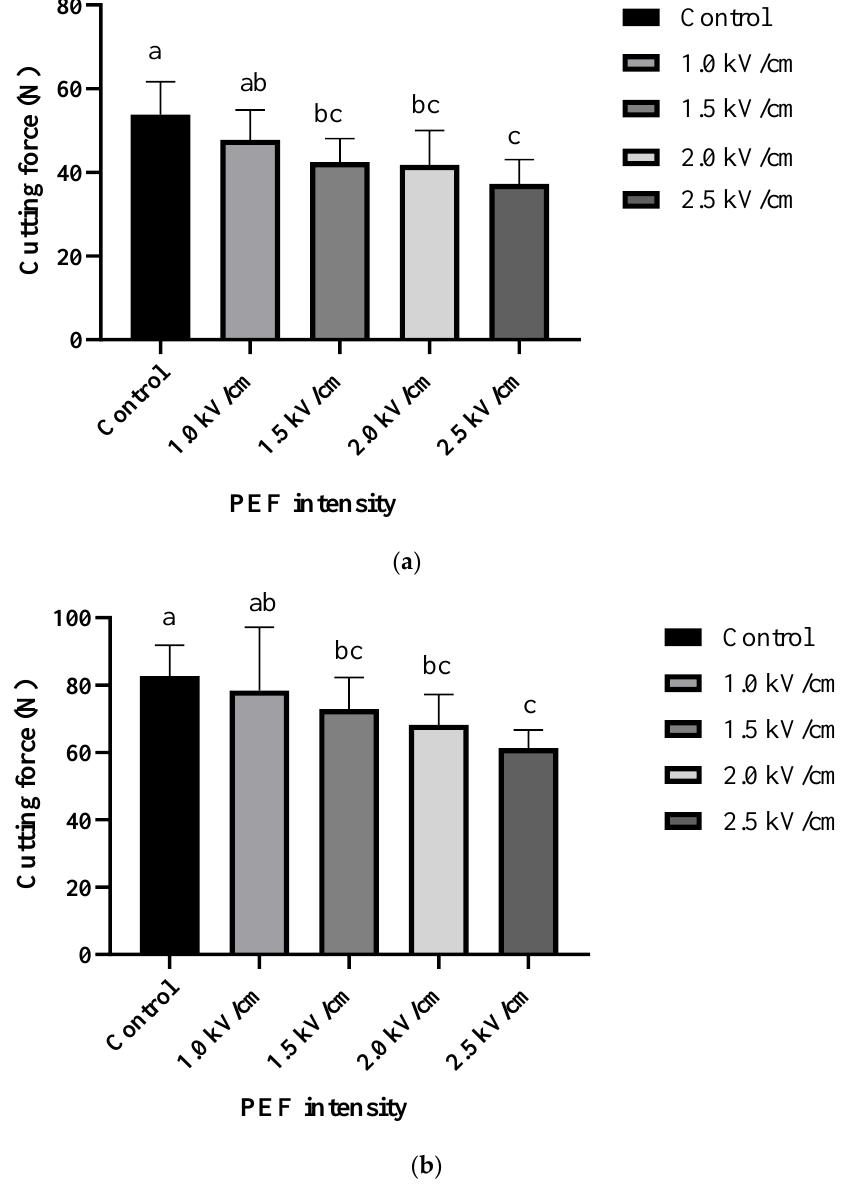
Figure 3. Cutting force ( a ) of carrot after treated by PEF and ( b ) cutting force of carrot after rehydrated at 90 °C. Control: carrot untreated by PEF; 1.0 kV/cm: carrot treated with PEF 1.0 kV/cm, 1.5 kV/cm: carrot treated with PEF 1.5 kV/cm; 2.0 kV/cm: carrot treated with PEF 2.0 kV/cm; 2.5 kV/cm: carrot with PEF 2.5 kV/cm (n = 3). Different letters (a – c) mean significant difference among different samples by Duncan’s multiple range test ( p < 0.05).